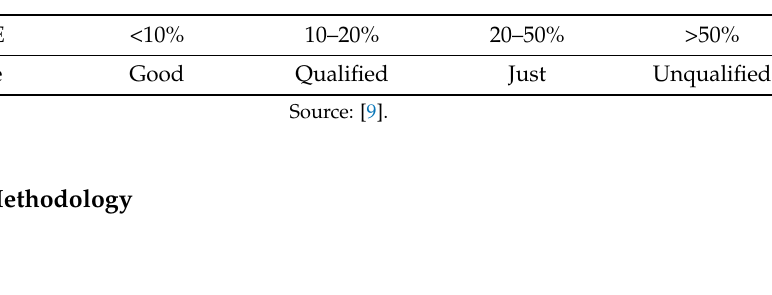
Table 1. Classes of reliability for Mean absolute percent error